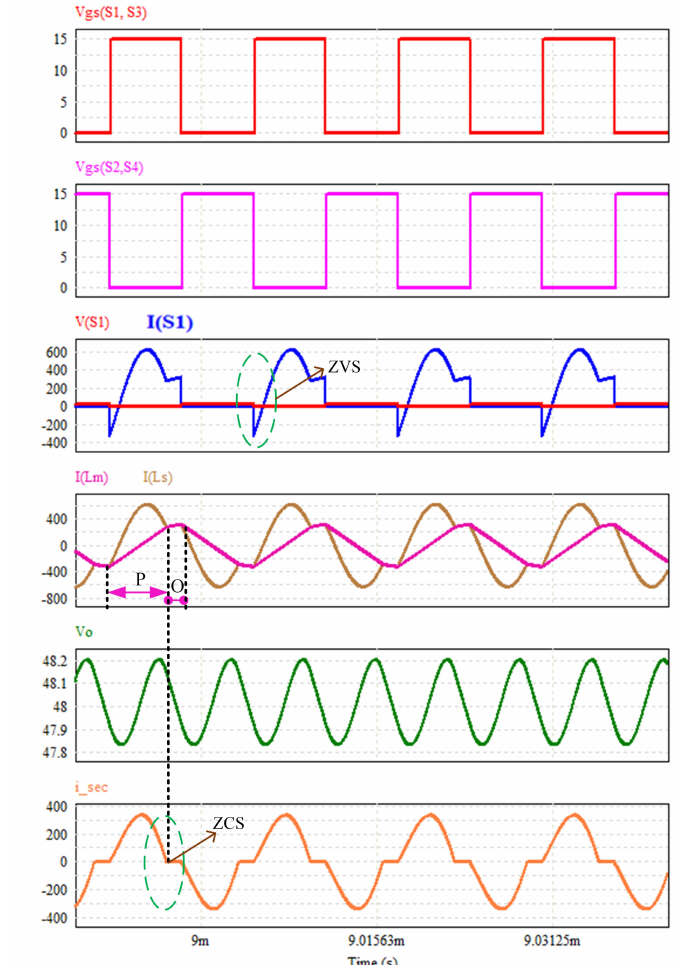
Figure 6. Simulations waveforms at minimum input voltage.